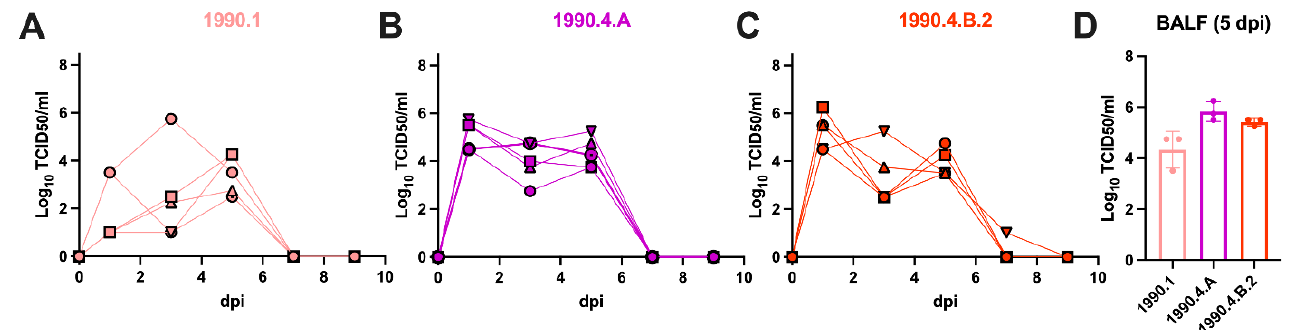
Figure 2. Infected pig nasal virus titers and BALF titers. Nasal shedding of H3N2 clades: 1990.1 ( A ), 318